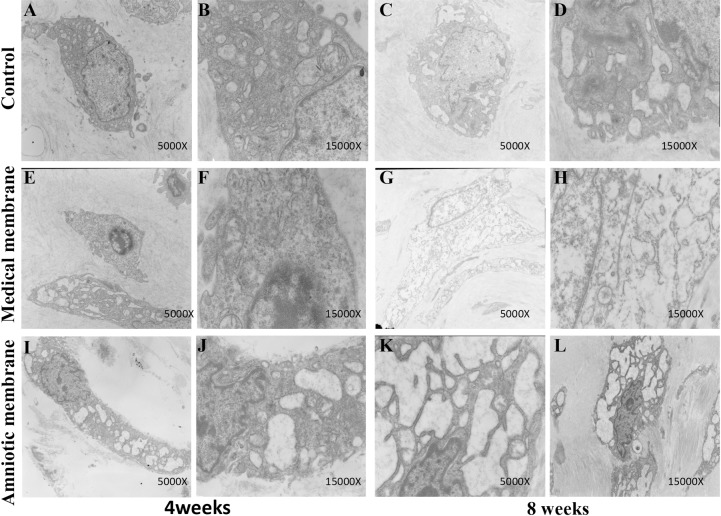
Transmission electron microscopy observations of the defection area of tendon sheath at the 4th and 8th week after operation.The number of synovial cells in the control group (A–D) was significantly lower than that of the two other groups. Moreover, the content of the rough endoplasmic reticulum in the cell matrix was low, and the extension degree was not evident. The medical membrane group (E–H) was similar to the amnion group, but the number of synovial cells was lower than that of the amnion group. Numerous synovial cells were observed in the amniotic group (I–L). Furthermore, numerous dilated rough endoplasmic reticulum and secretions in the endoplasmic reticulum were found in the matrix.